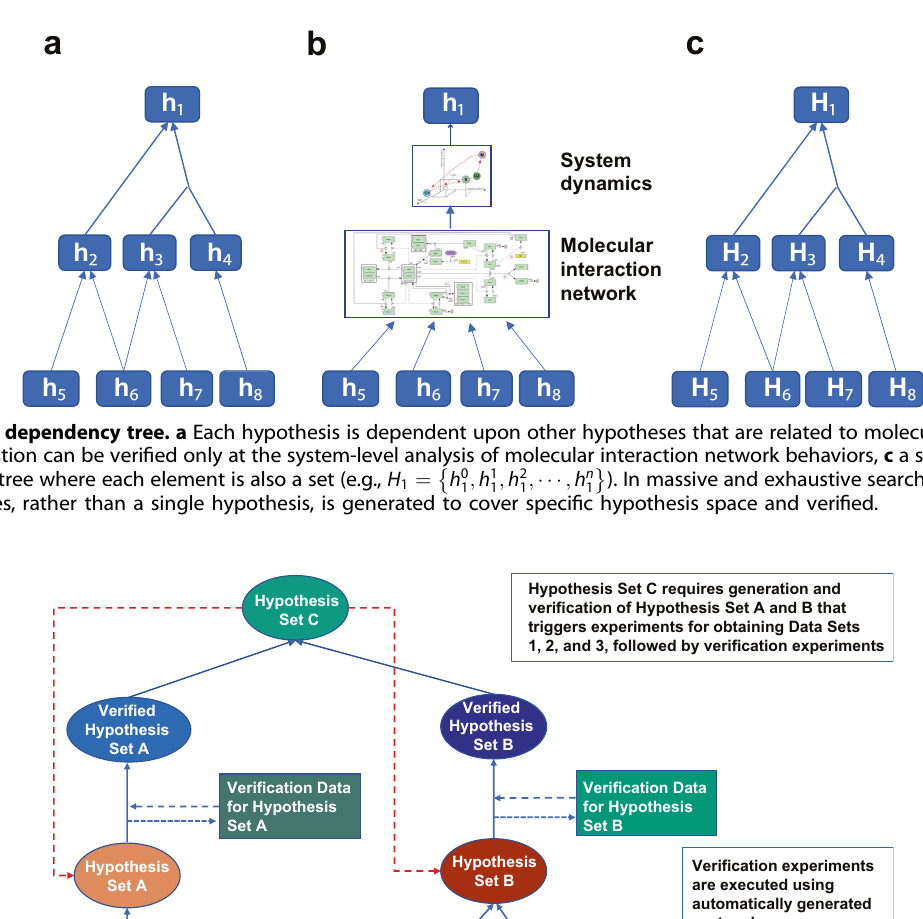
Fig. 5 Hypothesis tree. A hierarchical generation of hypothesis sets and data to verify them will be automatically generated and executed. Veri fi cation of Hypothesis set C requires both Hypothesis sets A and B to be veri fi ed. Veri fi cation data for Hypothesis sets A and B shall be obtained from experiments in general. In general, multiple data sets are required to fi ll various parameters of elements in Hypothesis set before fi nally tested in the veri fi cation process. This requires Data Set 1 for Hypothesis set A, and Data Sets 2 and 3 for Hypothesis set B need to be collected. Data sets 1, 2, and 3 can be obtained from databases, or through automated experiments. Veri fi ed Hypothesis sets A and B mean a set of elements of Hypothesis sets A and B that are veri fi ed to be true or entire sets with a score for each element. Given